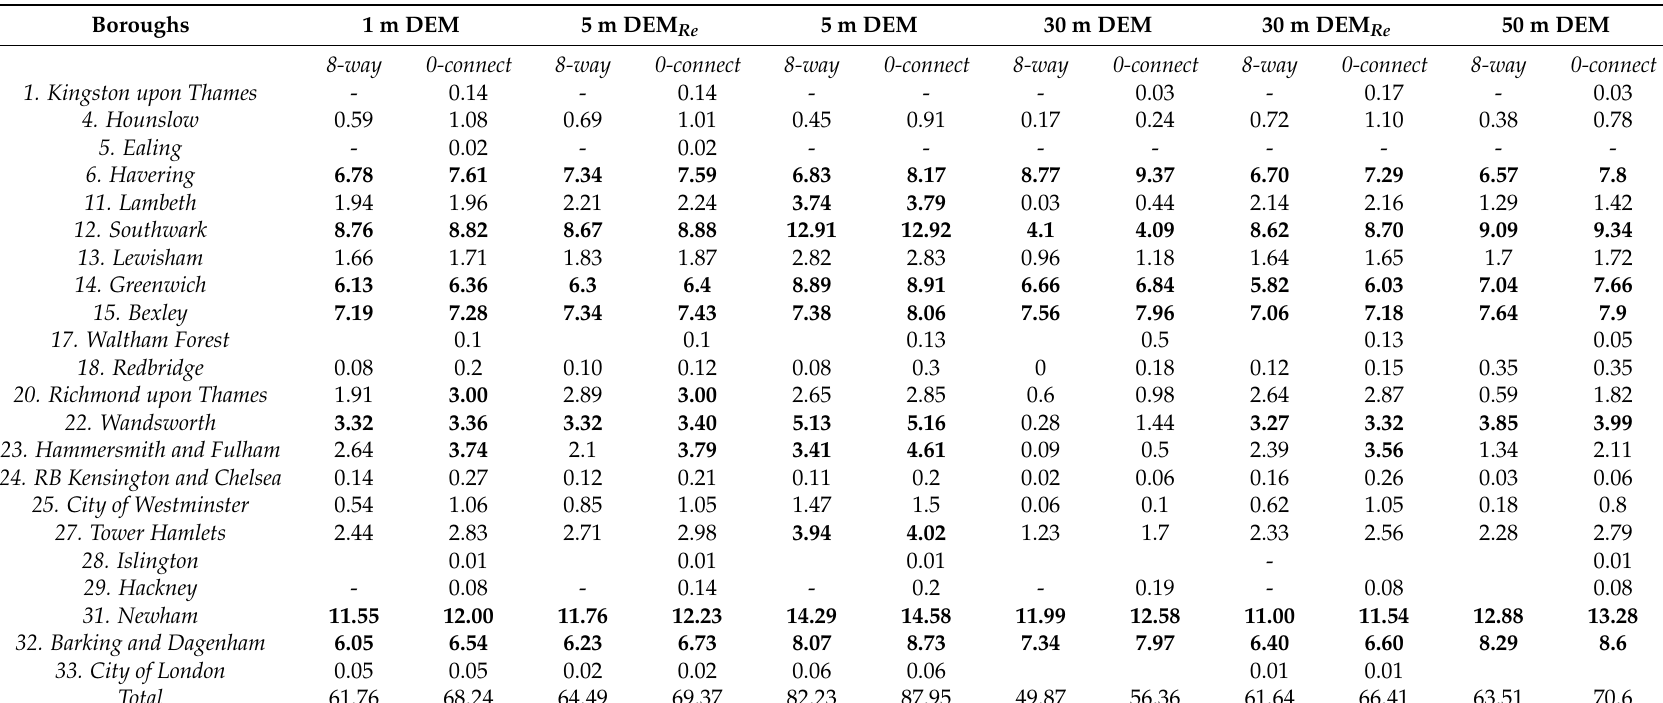
Table A1. Potential inundation areas for Greater London boroughs (in km 2 ) obtained from the 0.68 m UKCP09 London sea-level rise scenario as estimated from six different elevation datasets (Section 2.1) and two different connectivity (eight-way hydrological and zero) approaches (Section 2.2). Only the boroughs that will be impacted are included (compare with Figure 1). Bold values indicate boroughs having ě 3 km 2 inundation